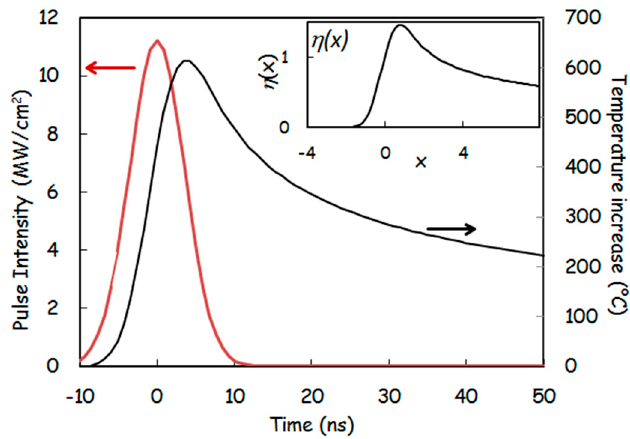
Figure 1. Increase in titanium surface temperature, ∆ T ( t ) , upon a single laser pulse radiation according to the parameters in Table 1. Inset: dimensionless function η (x)